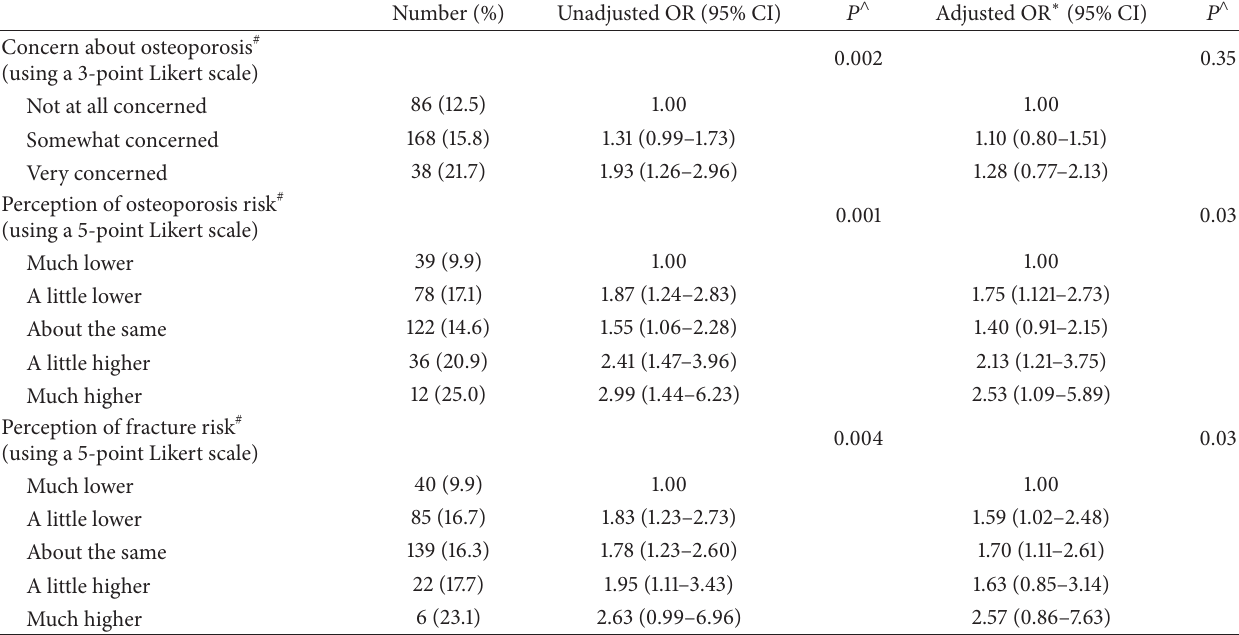
Table 4: Odds ratio (ORs) of bone mineral density (BMD) testing in the next 12 months for covariates about concern and risk perception of osteoporosis (limited to assessments with non-BMD testing in the previous year !